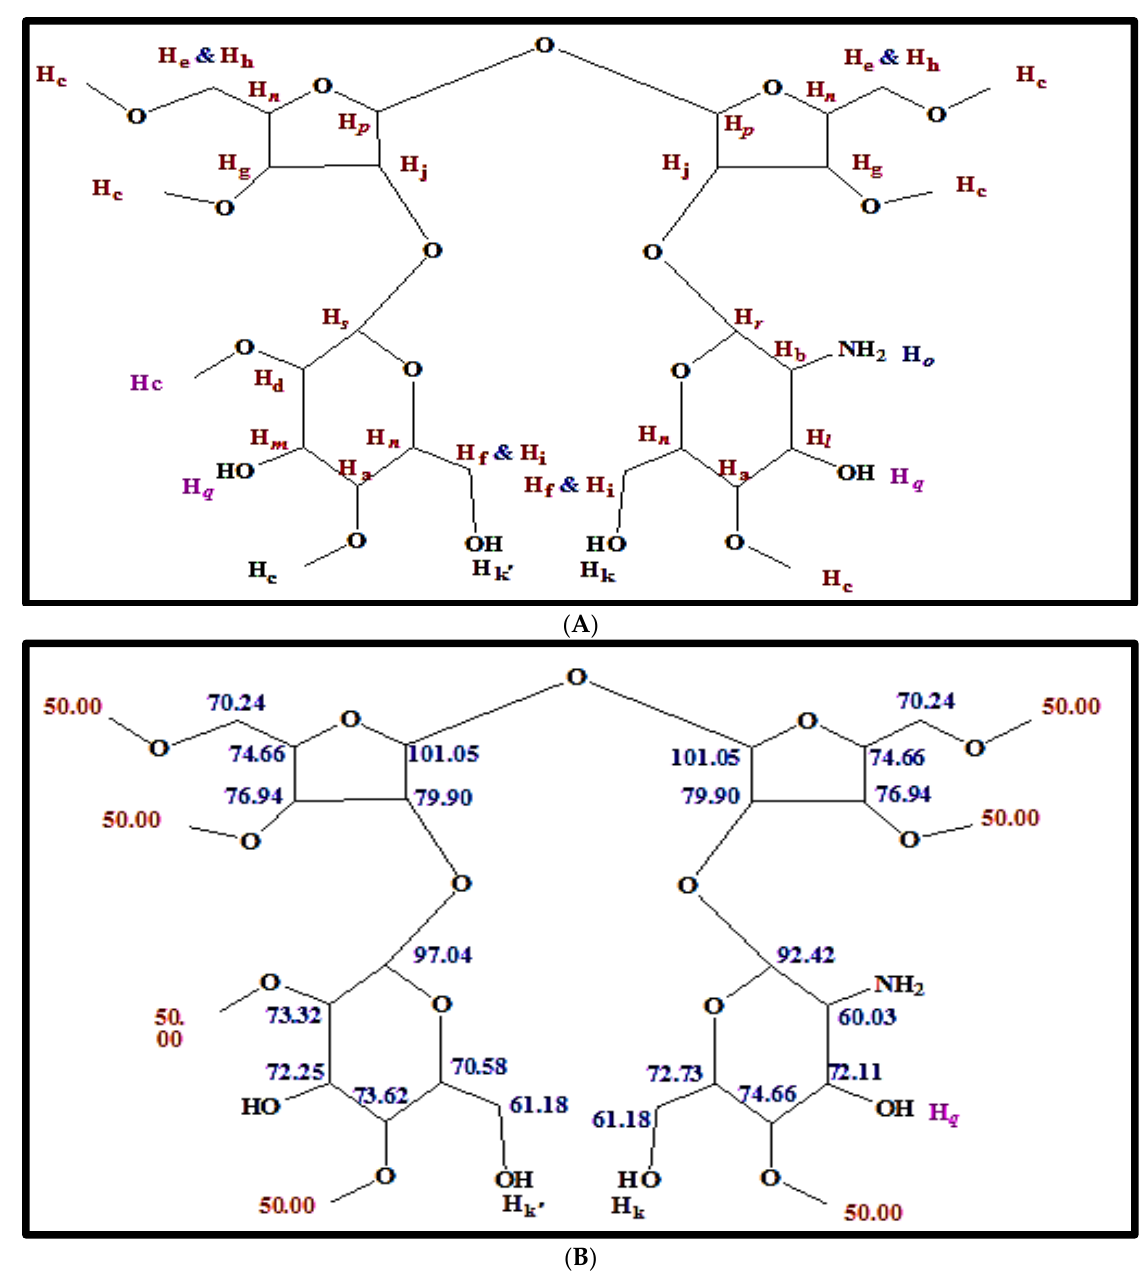
Figure 8. ( A ) Chemical structure of antibacterial agent (fraction 6) and chemical shift values of hydrogen ( 1 H-NMR) by letters. ( B ) Chemical shift values of the carbon atoms ( 13 C-NMR) displayed in antibacterial compound.